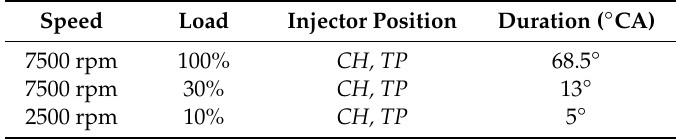
Table 6. Injection setup used in computational fluid dynamics (CFD)